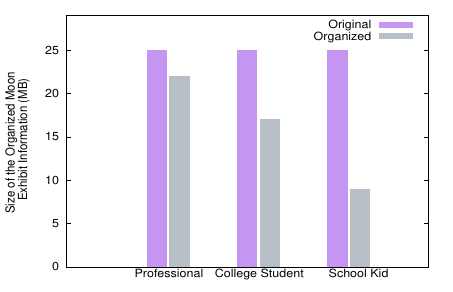
Figure 10. Variation in Size of Organized Exhibit Information of Moon for the Museum